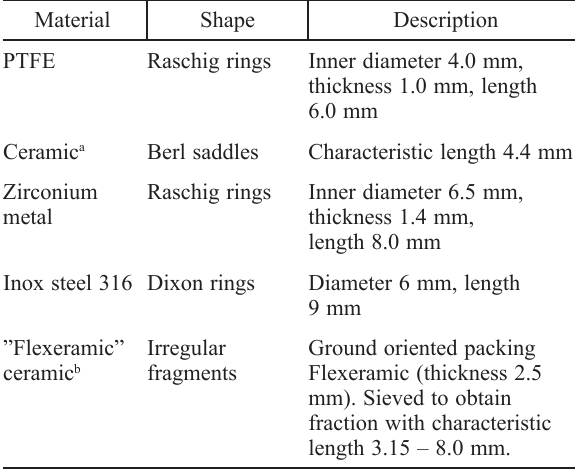
Table 3 – Characteristics of the materials used as column